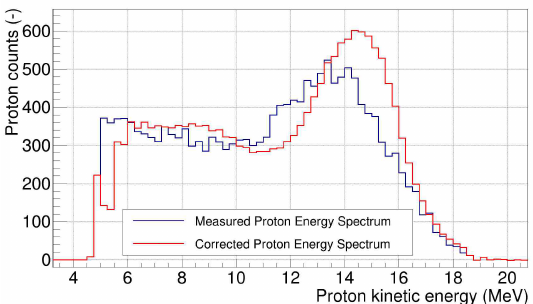
Figure 4. Proton energy spectra measured by PRT (blue) and corrected proton energy spectra (red).